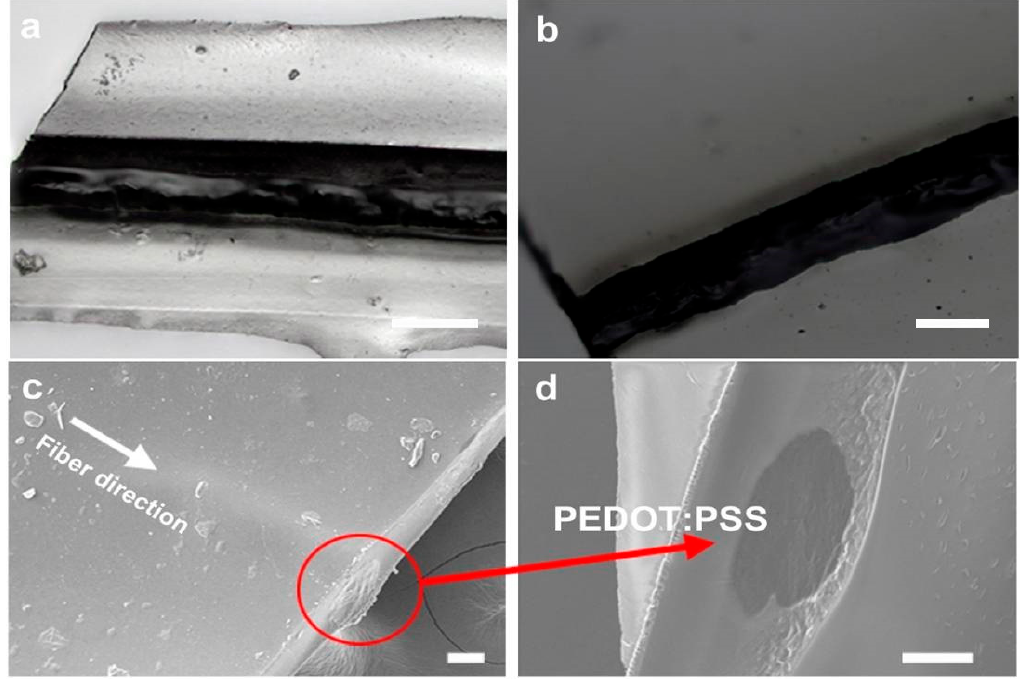
Figure 5. ( a, b ) Optical imaging of upper and lower surfaces, showing the sheathed dark conducting PEDOT:PSS wire enclosed in the transparent fibroin sheath. ( c ) SEM imaging of the sheathed wires. ( d ) Cross-section across the wire showing the dark fiber surrounded by the insulating silk matrix. Scale bar = 50 µm in all panels.